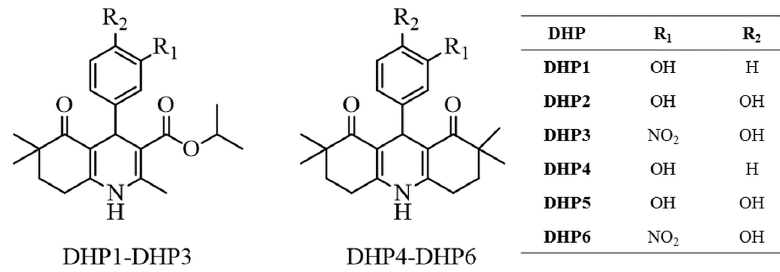
Figure 1. Chemical structures of the synthesized compounds .